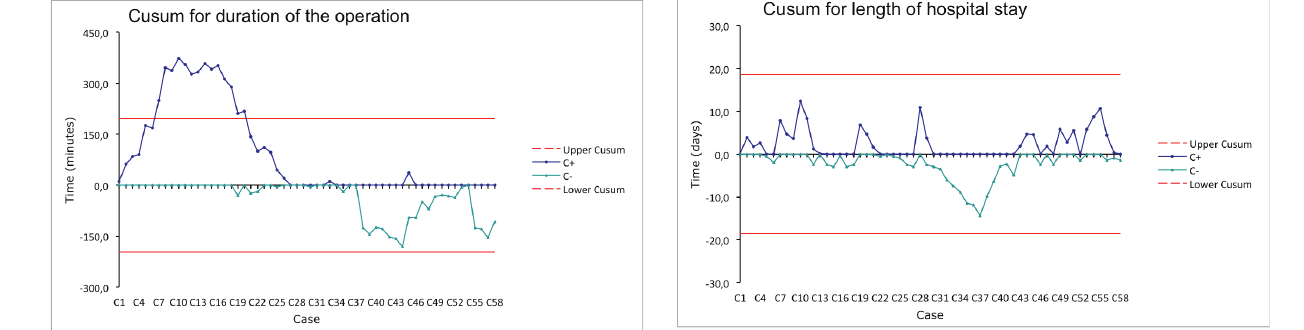
Graph 1: CUSUM chart for durations of the operations. Consistency (no slope) is being reached at 27 cases presenting the target number for technical proficiency of VATS lobectomy.